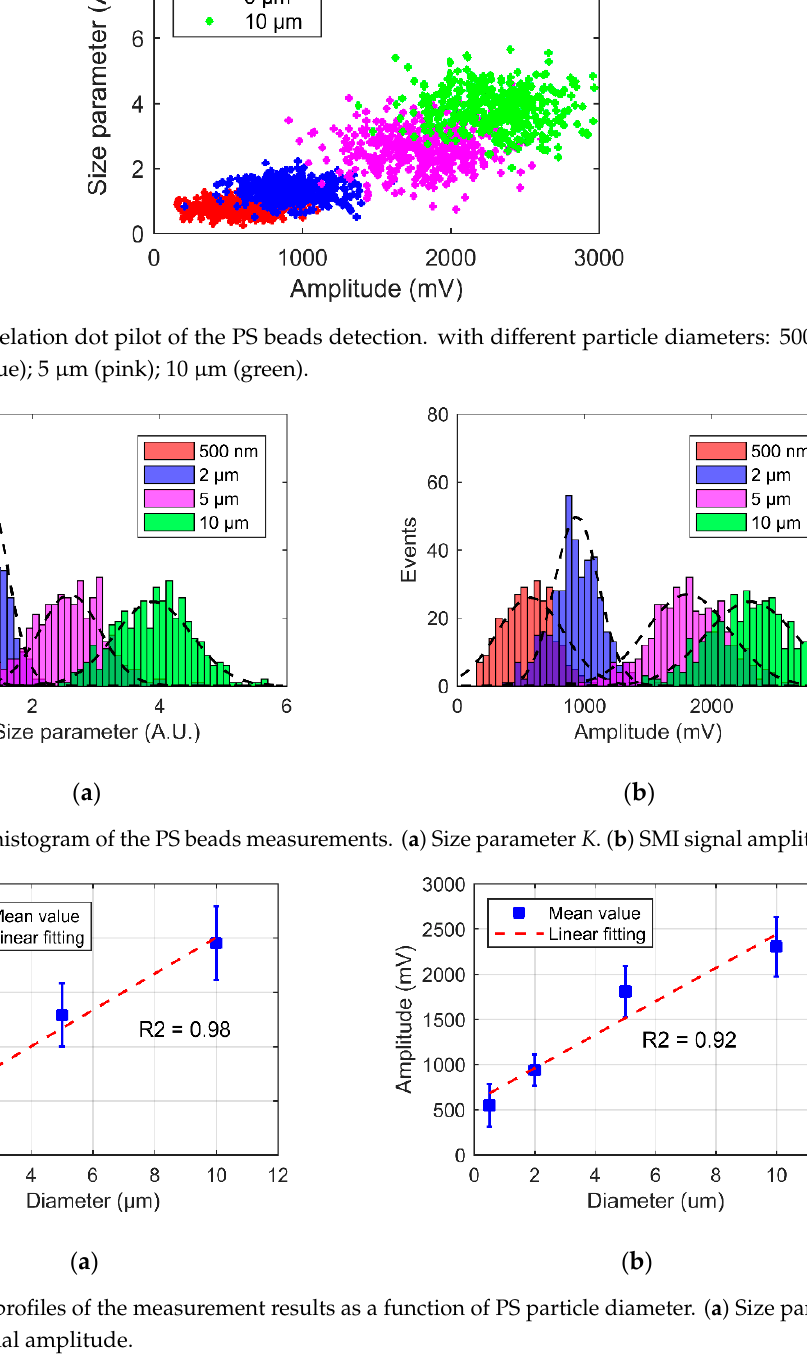
Figure 9. The profiles of the measurement results as a function of PS particle diameter. ( a ) Size particle K . ( b ) SMI signal amplitude.